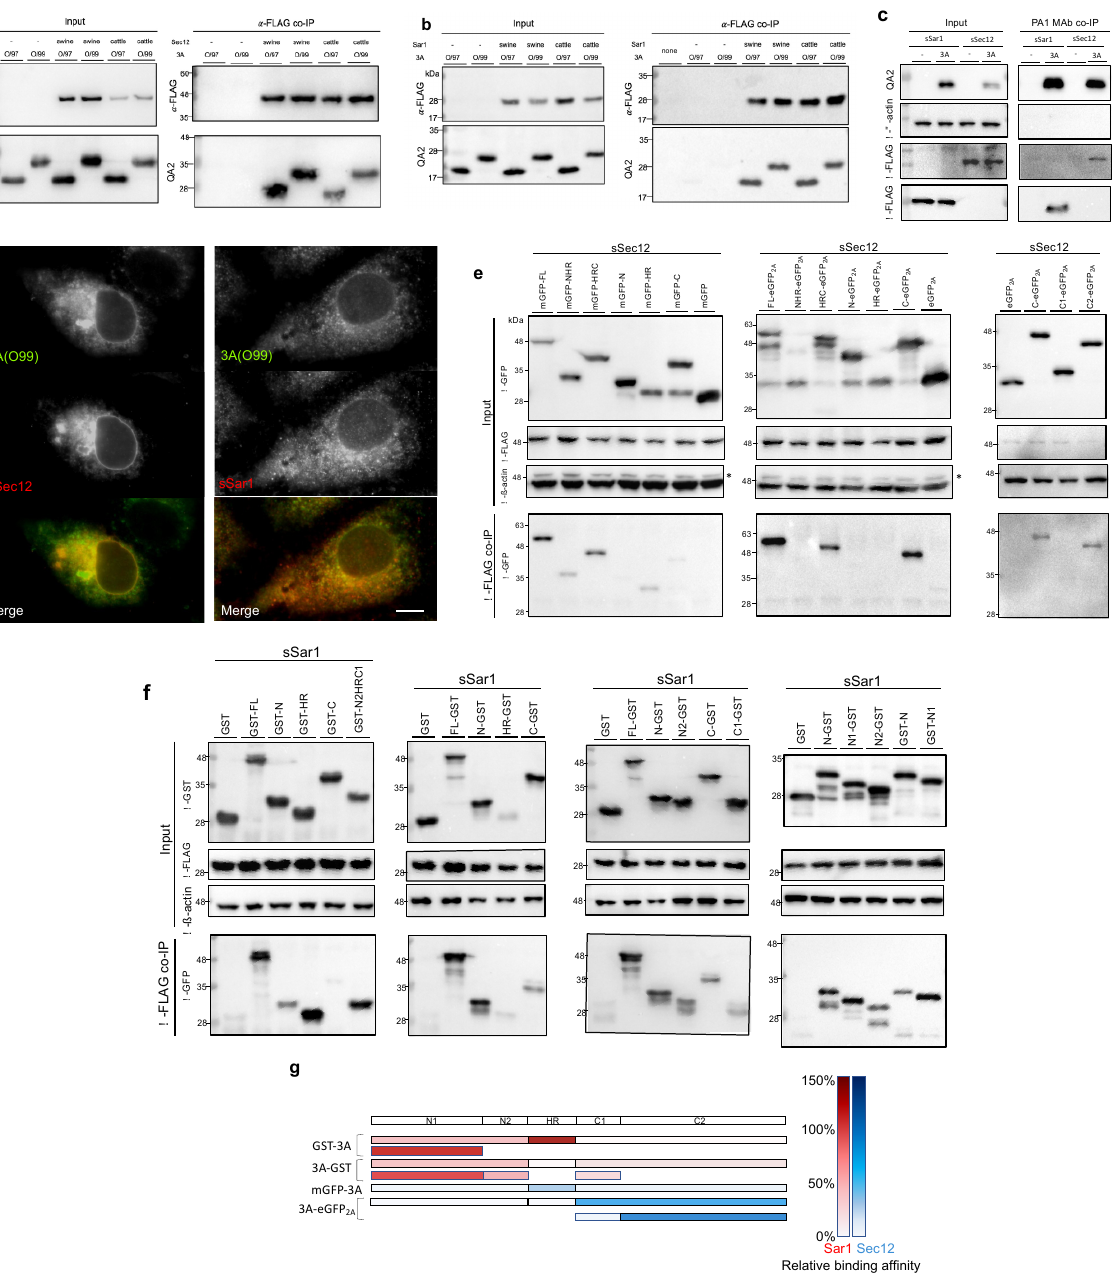
Figure 5. The examination of interactions between 3A and Sec12 or Sar1. ( a ) In the vTF7-3 expression system, HTK cell lysates for the co-expression of 3A from O/97 or O/99 and Sec12 from swine or cattle were applied to anti-FLAG co-immunoprecipitation assays: empty vector, pcDNA 3.1(+), none: non-transfection. ( b ) The examination for Sar1 was performed using the same procedure. ( c ) Reciprocal co-immunoprecipitation was performed with anti-3A MAb PA1. ( d ) PK-15 cells co-expressing 3A (O99) with sSec12 or sSar1. The cells were double-labeled for 3A and recombinant COPII factors using MAb QA2 and anti-FLAG rabbit antibodies, followed by anti-mouse and anti-rabbit secondary antibodies conjugated with Alexa Fluor 647 (green) and Alexa Fluor 594 (red), correspondingly. Scale bar, 10 µm. ( e ) PK-15 cells co-expressing sSec12 with variant truncation GFP version for anti-FLAG co-immunoprecipitation. *: residual signal for Sec12. ( f ) Co-expression of sSar1 with the truncated GST variants in the vTF7-3 system was applied for co-IP. ( g ) The diagram represents the relative binding affinity of each part of Sar1 or Sec12. The protein level of full-length 3A from the elution was regarded as 100%. Due to a relatively low expression level, HR-GST for Sar1 was excluded.